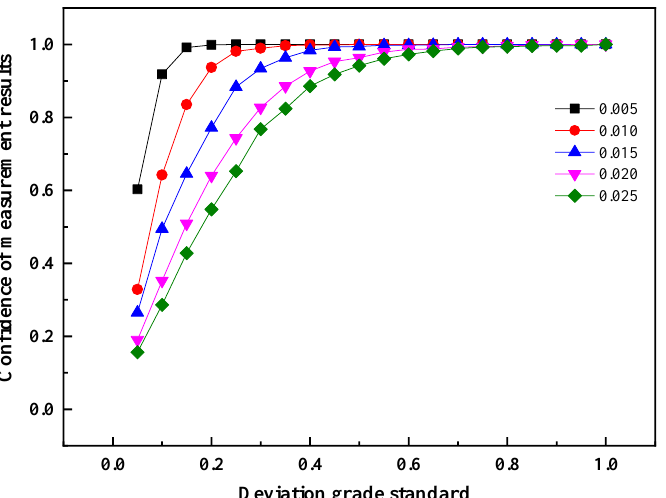
Figure 23. Relationship between deviation grade standard and confidence of measurement results under different relative standard deviations of temperature at velocity 5.05 m/s.